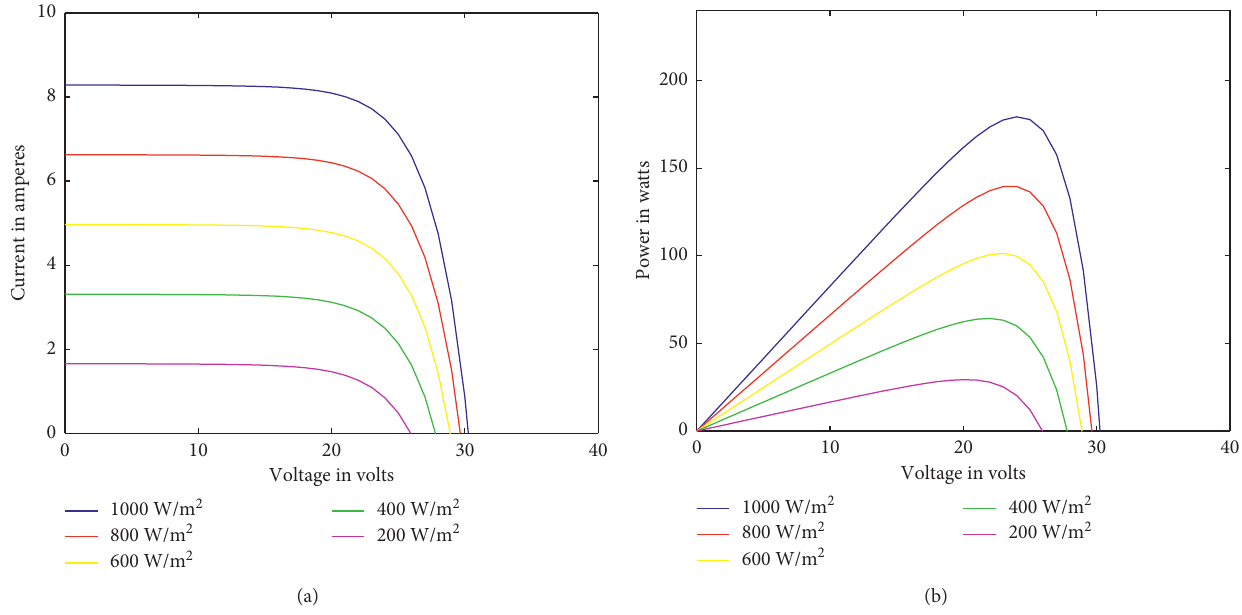
Figure 10: IV and PV curves for KC200GTshowing different irradiance values at 1000W/m 2 , 800W/m 2 , 600W/m 2 , 400W/m 2 , and 200W/m 2 , for NOCT � 47 ° C. (a) KC200GT IV curve for NOCT � 47 ° C. (b) KC200GT PV curve for NOCT � 47 °